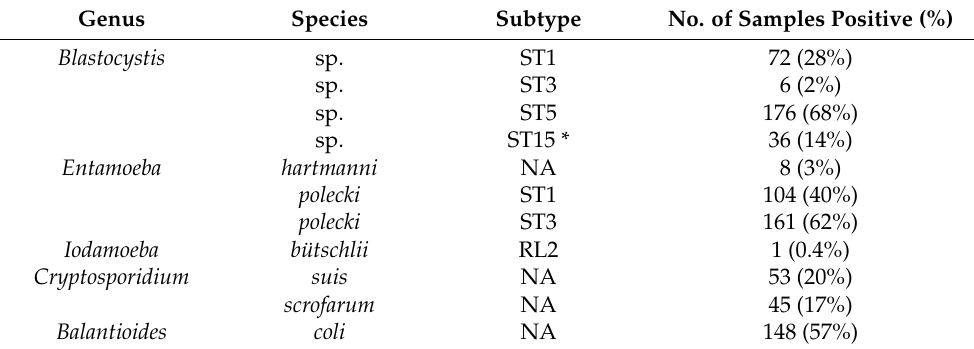
Table 5. Parasitic species and subtypes of Balantioides , Cryptosporidium , Entamoeba , and Blastocystis identified by cluster analysis of metabarcoding data obtained from 259 fecal DNAs from pigs from four different herds in